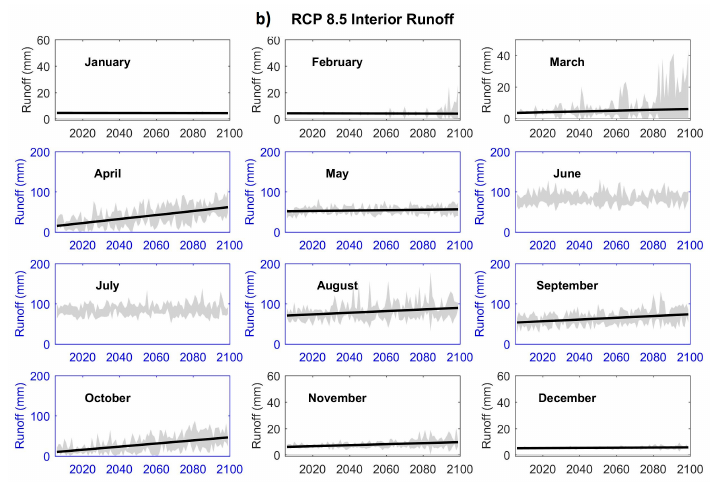
Figure 6. Trends in monthly runoff for scenarios RCP 4.5 ( a ) and RCP 8.5 ( b ) from the interior portion of the watershed, which comprises the Alaska Range, the Wrangell Mountains, and the forested river valley. Gray shaded regions display one standard deviation around the mean of five CMIP5 models, and where a solid black trendline is present, it indicates the presence of a statistically significant trend in the five-model mean simulations (MM45 or MM85). Runoff during high-flow months (identified by blue axes) is illustrated at a different scale than during low-flow months (black axes).